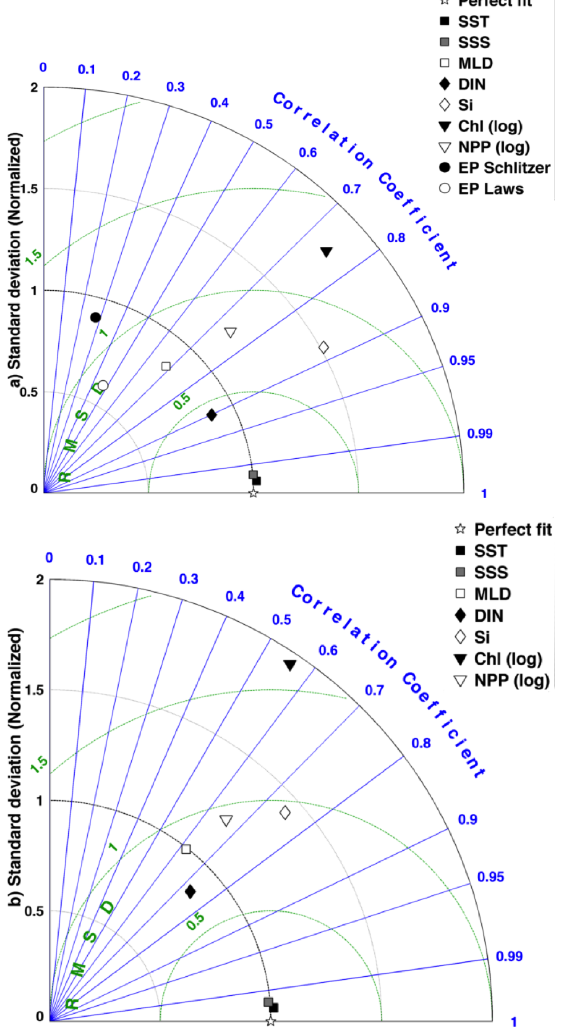
Figure 4. Taylor diagrams (Taylor, 2001) showing correlation, nor- malized SD and the normalized root mean square error between values of the model results and observations (Table 1), weighted by area. (a) Spatial distribution; (b) spatial–seasonal distribution. All values are surface values, except the mixed layer depth and the vertically integrated NPP. (a) Uses the yearly mean calculated over 2004–2008 and (b) uses the monthly means of the same years. All fields have been interpolated to a 1 ◦ × 1 ◦ grid, using linear interpo- lation.